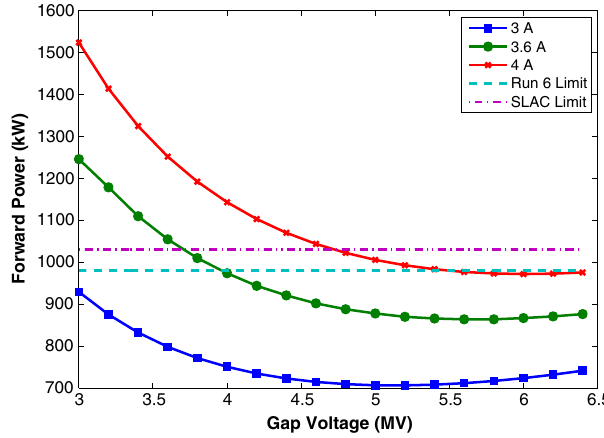
FIG. 8. (Color) LER klystron forward power versus gap